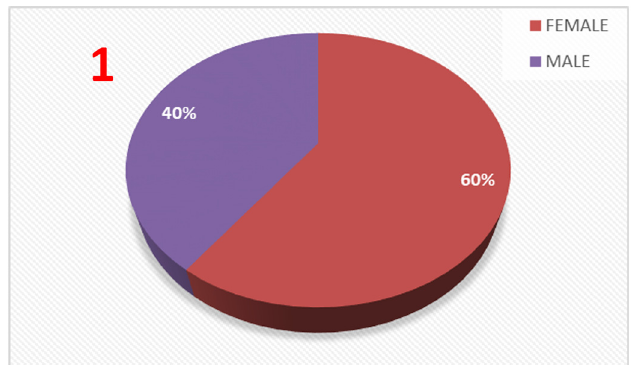
Fig. 1. Male-Female ratio in this study who assessed pre and post- operatively all 3